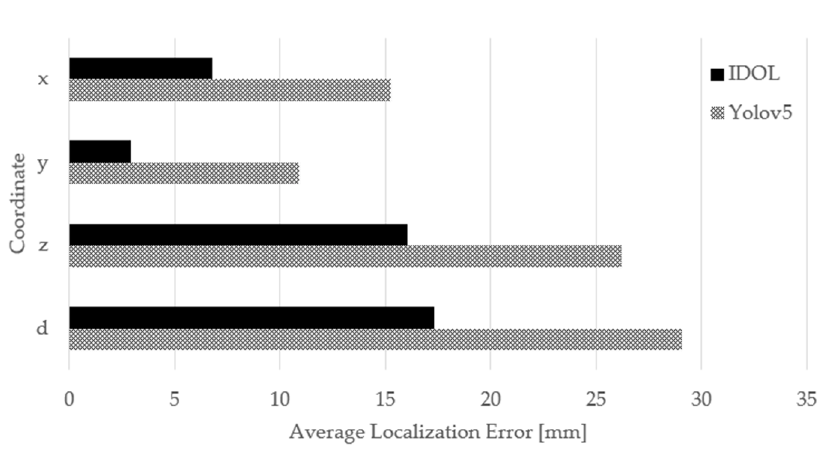
YOLOv5 localization in 3D point cloud data.